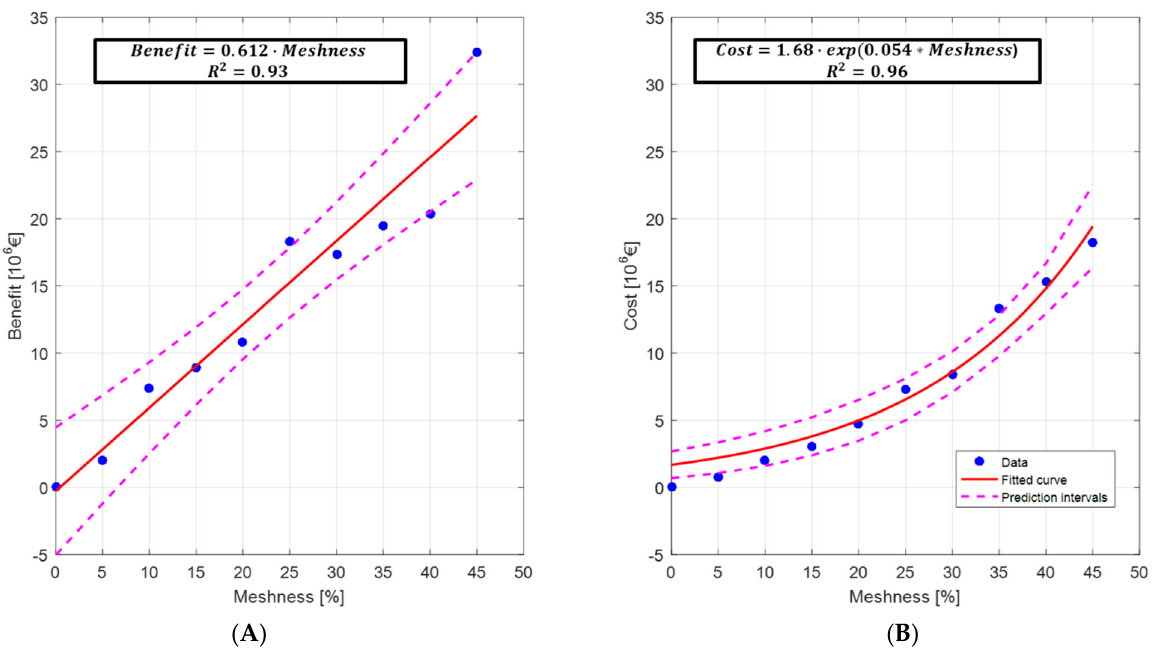
Figure 4. Regressions between benefits ( A ) and costs ( B ) as a function of Meshness. Including fitted lines, their 95% prediction interval (red and magenta lines, respectively).